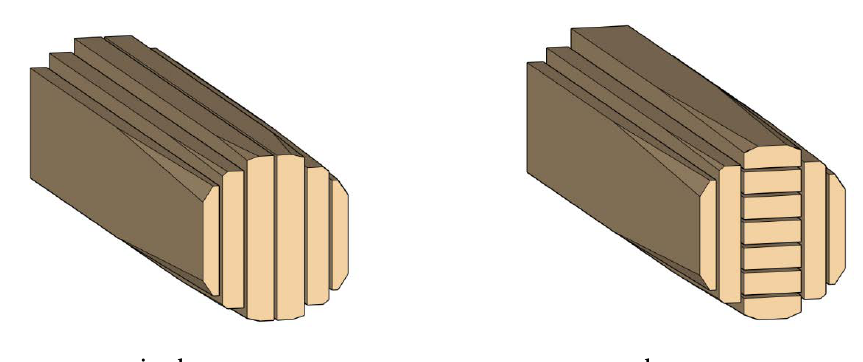
Figure 4. Log conicity.